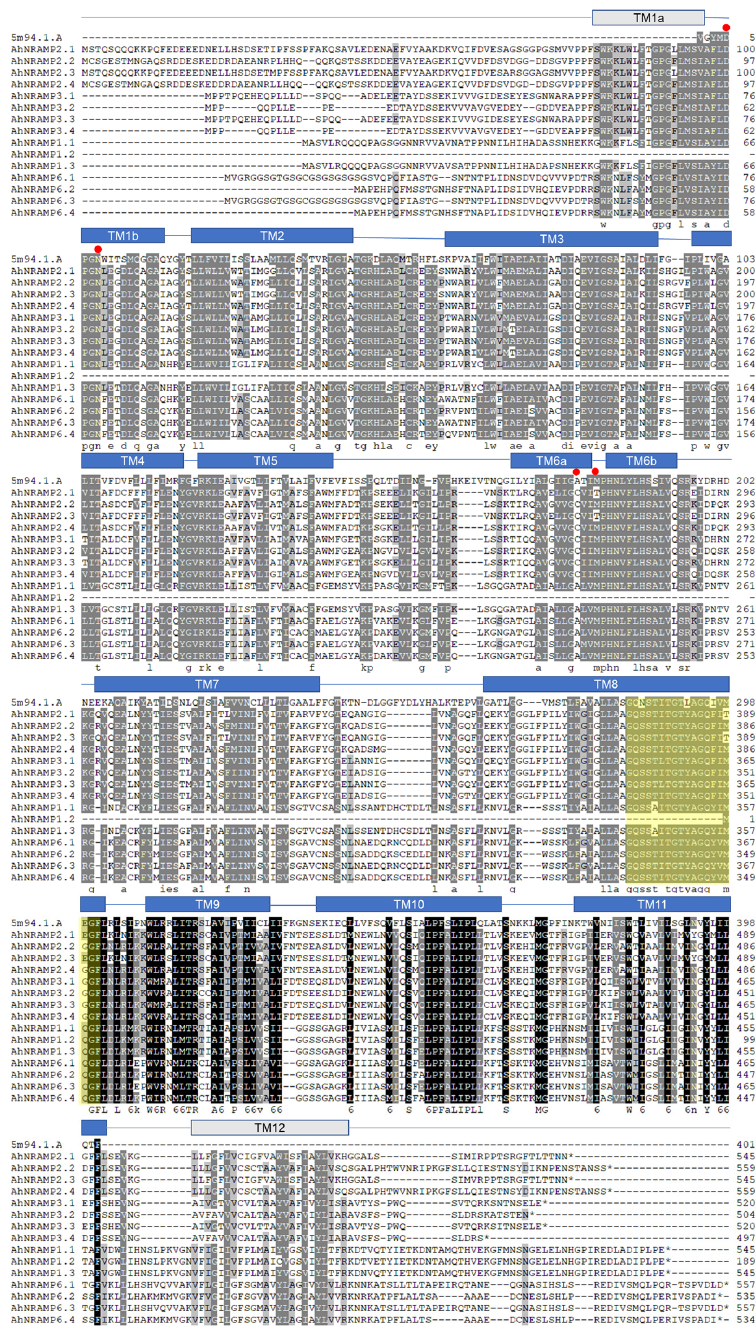
Figure 5. Sequence alignment of ScaDMT and AhNRAMP with ClustalW. Identical residues are highlighted in black and homologous residues in gray, while the typical conserved amino acid residues GQSSTITGTYAGQY(/F)V(/I)MQ(/G/E)GFL are highlighted in yellow. Secondary structure elements are shown above the sequences. The red circles indicate residues of the transition metal binding site in ScaDMT.